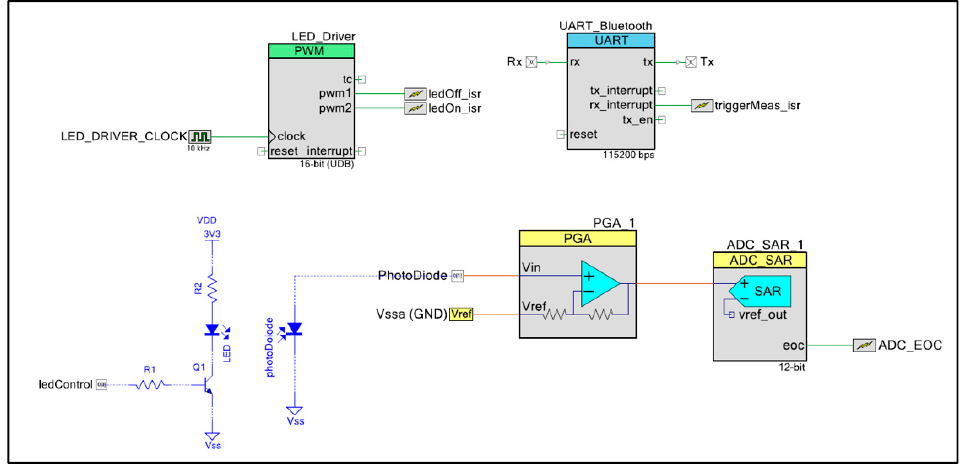
Figure 6. Diagram block of the developed instrument showing the electronics part and the measurement setup.